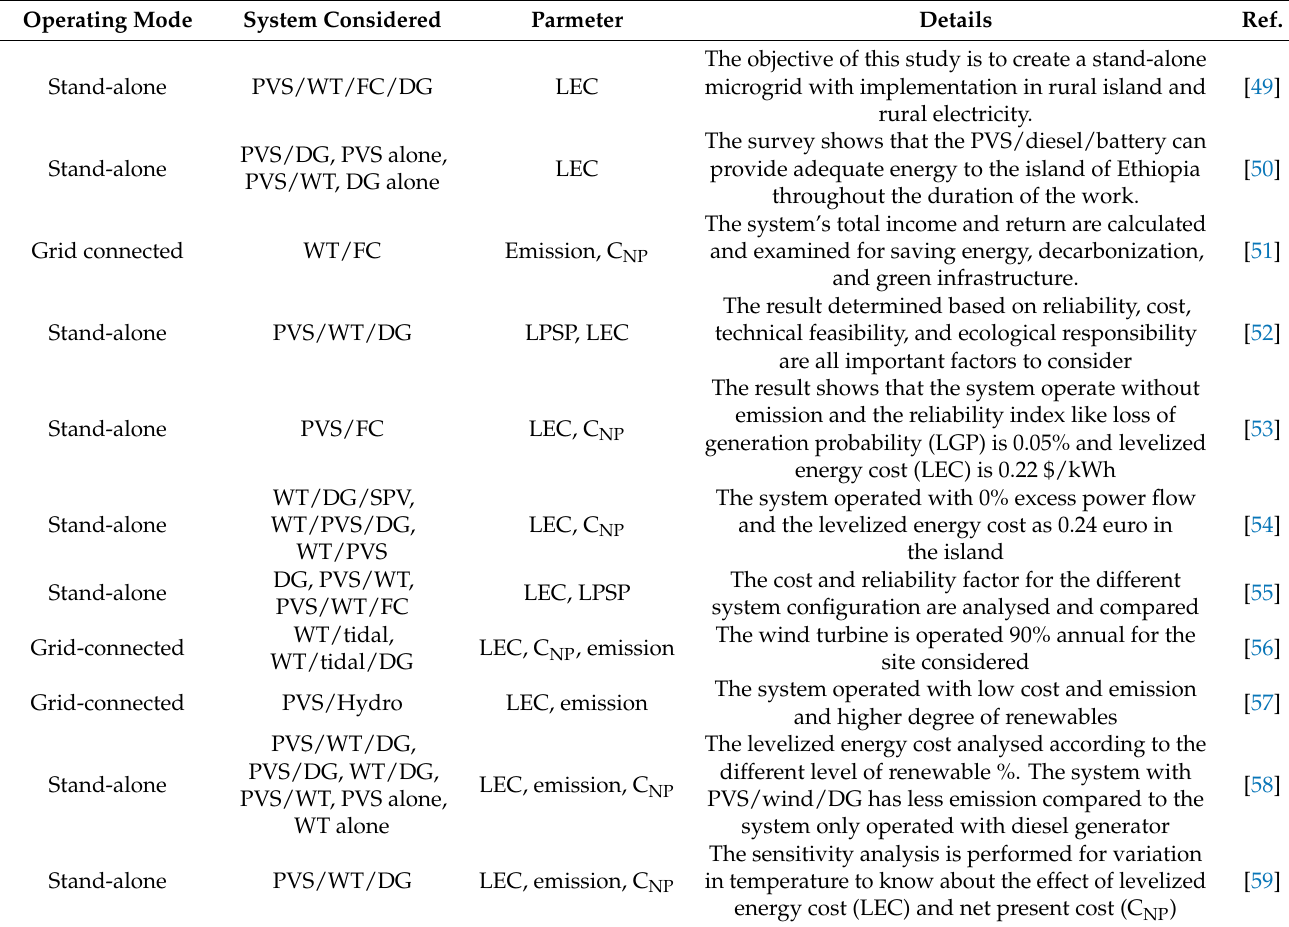
Table 1. Survey of the hybrid system using